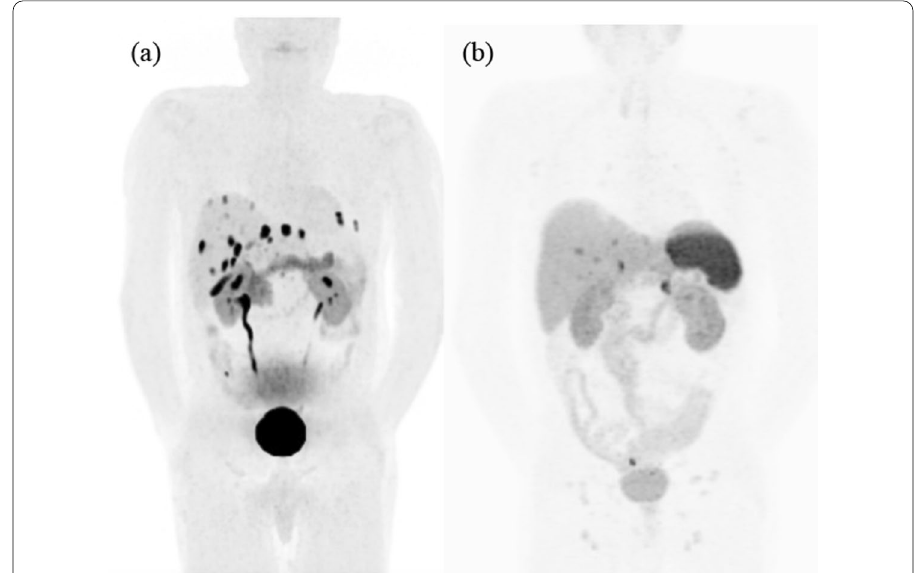
Fig. 2 18F-DOPA PET/CT MIP ( a ) and 68Ga-HA-DOTATATE PET/CT MIP ( b ) performed 22 days